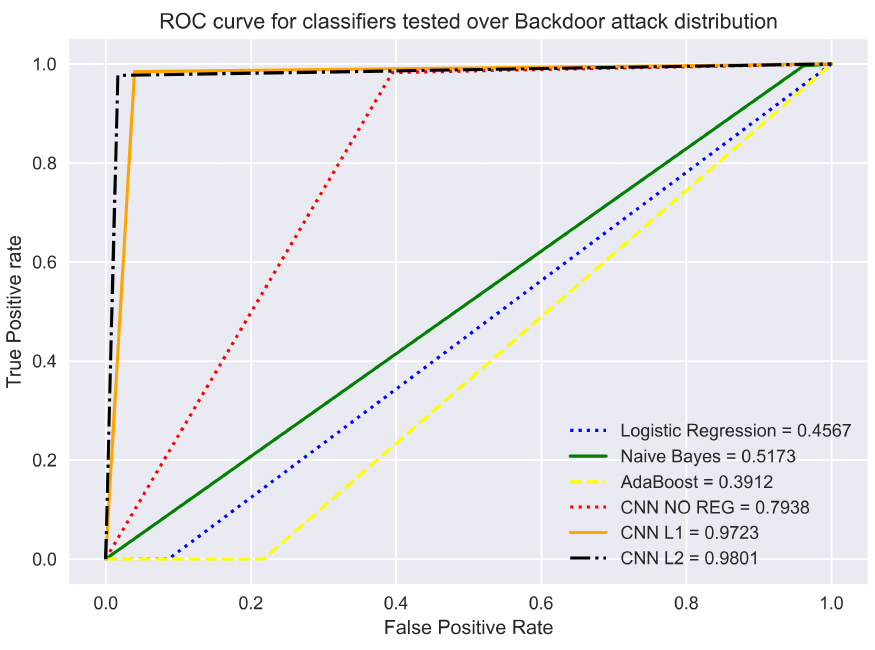
Figure 3. Plot of all classifiers’ ROC In Scenario